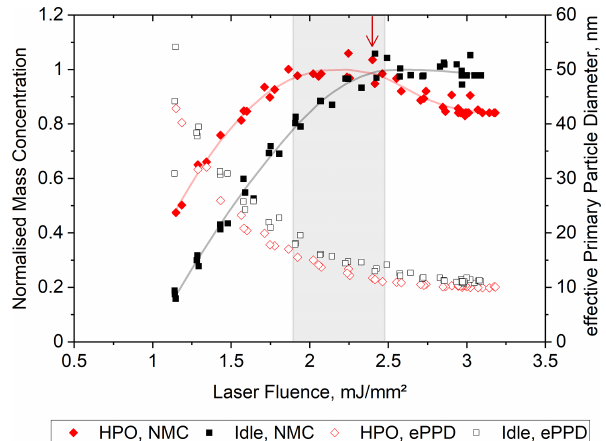
Figure 4. Normalised mass concentration (NMC) mean and the derived effective primary particle diameter (ePPD) mean across the different laser fluence levels using the nvPM source from the kerosene-fuelled Rig A at high power output (HPO) and at idle conditions (idle). The shaded area indicates the ± 2% data range of the HPO case. The arrow indicates an optimum laser fluence level for real-time nvPM mass concentration measurements for all power